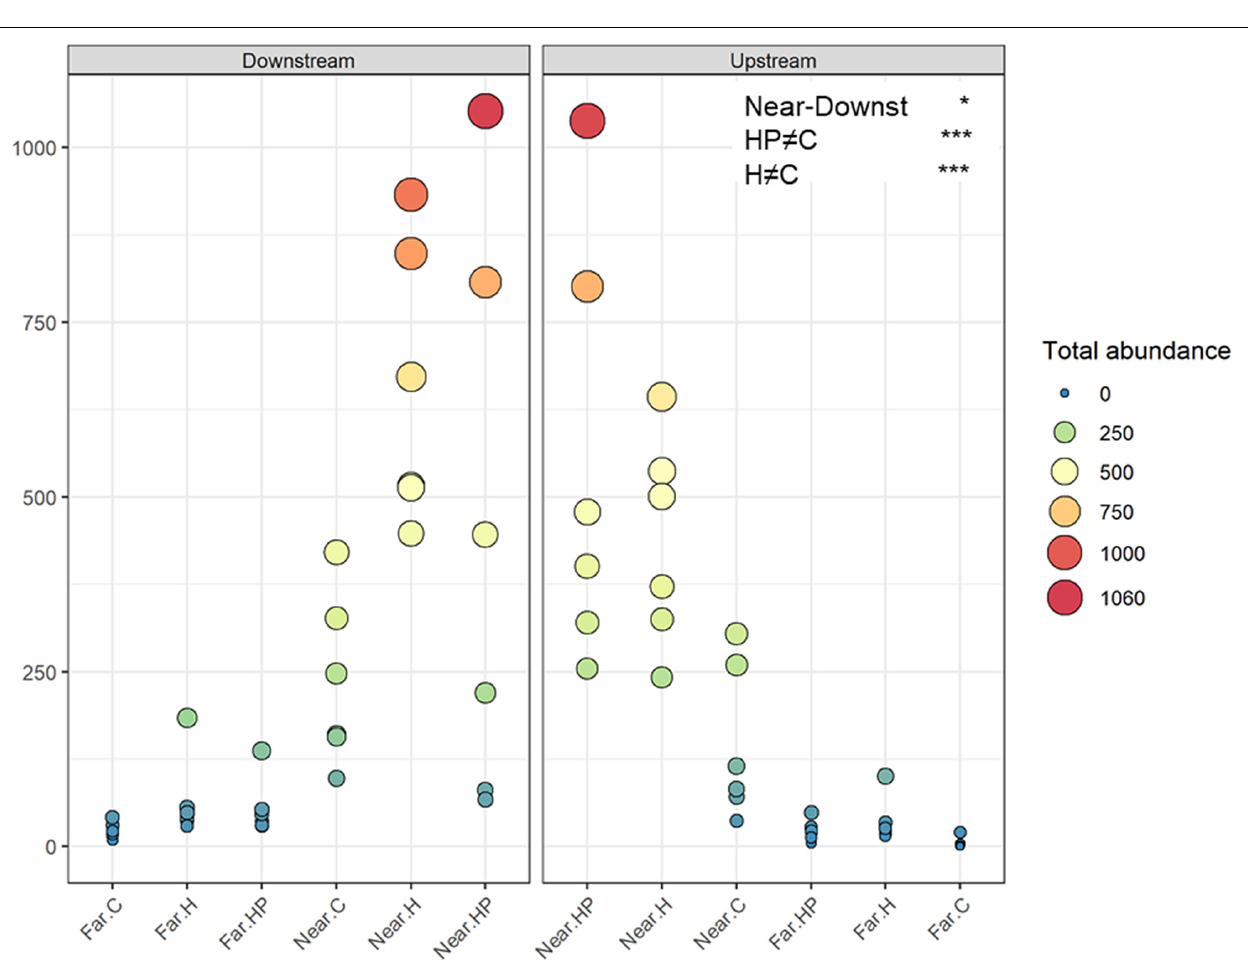
FIGURE 3 | Mean total abundance of amphipods in the different ACs containing habitat and feed pellets (HP), only habitat (H) or control (C) located near and far downstream and near and far upstream. Significant GLM results are expressed as * p < 0.05 and *** p <